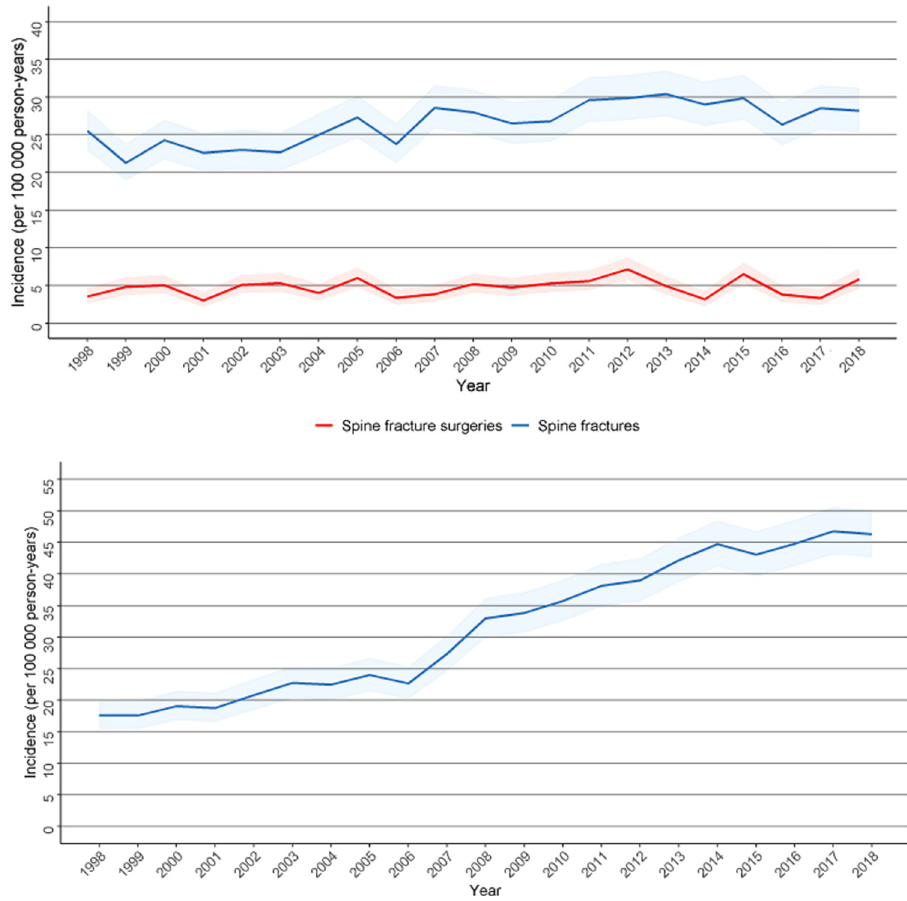
Fig 2. A. Incidence of spine fractures and spine fracture surgeries with 95% confidence intervals among fertile-aged (15–49 years) women during the study period. B. Incidence of fusion surgeries for other reasons with 95% confidence intervals among fertile-aged (15–49 years) women during the study